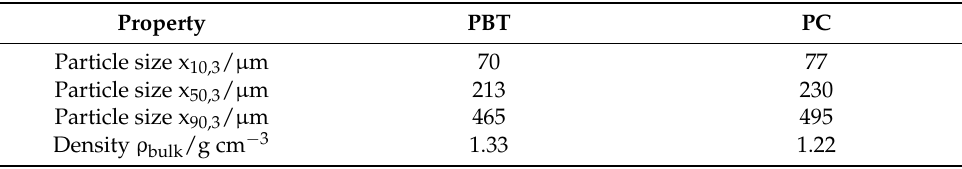
Table 1. Properties of PBT and PC raw material particles (self